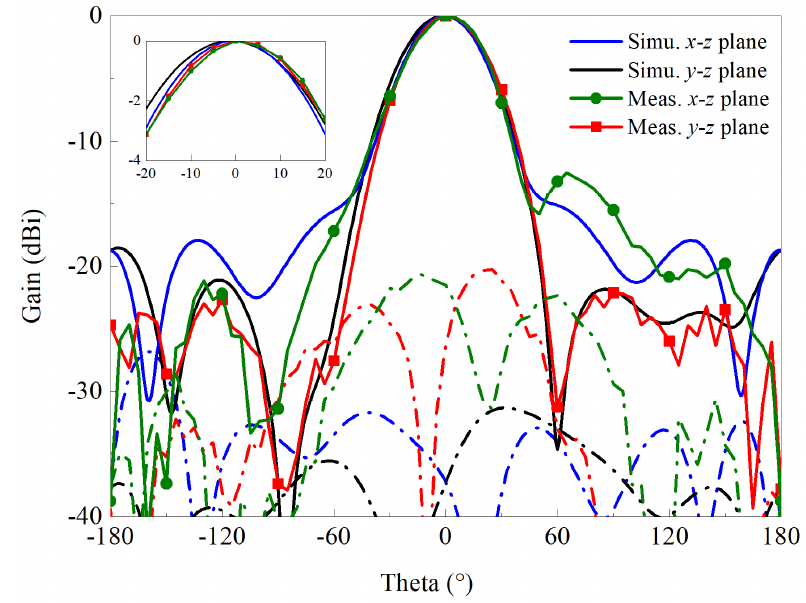
Figure 14. Simulated and measured normalized radiation patterns at 5.8 GHz.